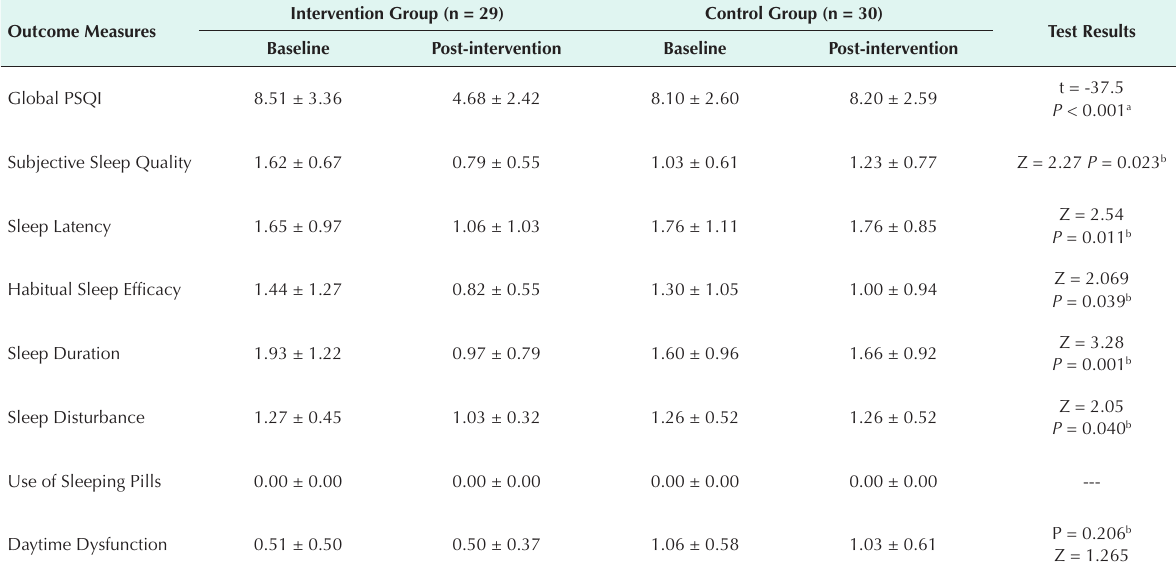
Table 2. Comparisons of PQSI Scores at Two Time Points in Two Study Groups Outcome